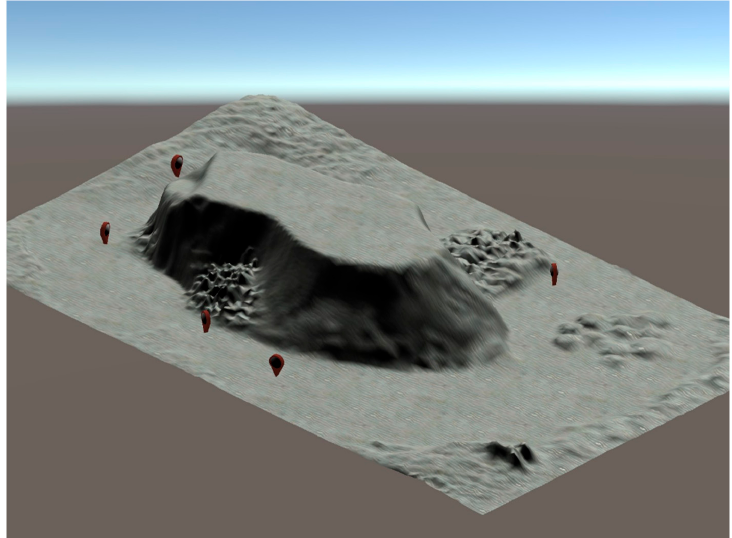
Figure 5. A sample of a seamount.